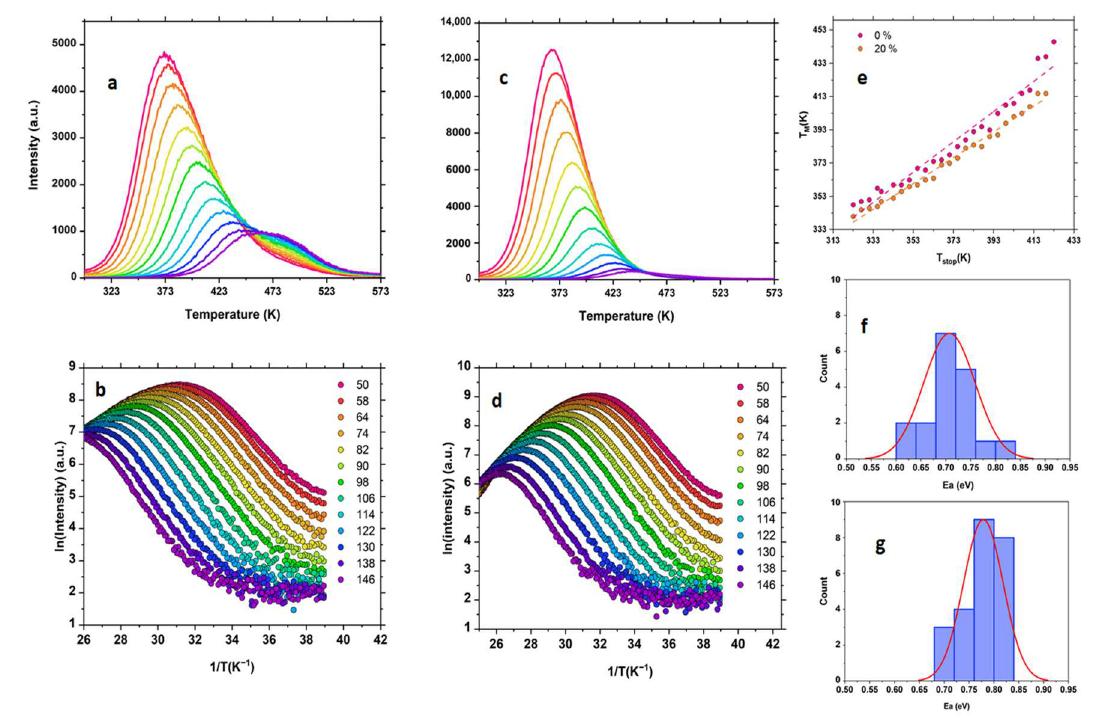
Figure 5. ( a ) Application of T M -T stop for x = 0% and ( b ) initial rise method applied for x = 0% samples. For clarity, selected temperatures were plotted. The temperature variation was 4 K. ( c ) Application of T M -T stop for x = 20% and ( d ) initial rise method applied for x = 20%. ( e ) T M -T stop for both samples. The linearity indicates a continuous trap distribution. ( f , g ) Representative distribution of the activation energy obtained in the initial rise method, respectively.